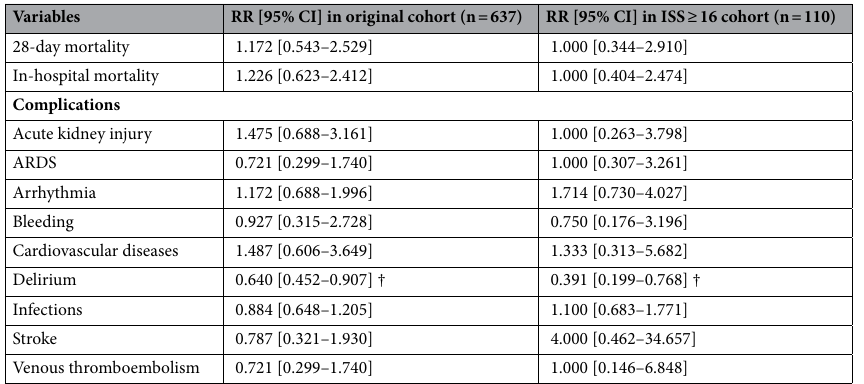
Table 3. Outcome events of sensitivity analyses. The RRs to each variable for the use of antihypertensive drugs were evaluated. † The results were considered statistically significant based on 95% CI. ARDS Acute respiratory distress syndrome, ISS Injury severity score, CI Confidence interval, RR Relative risk.